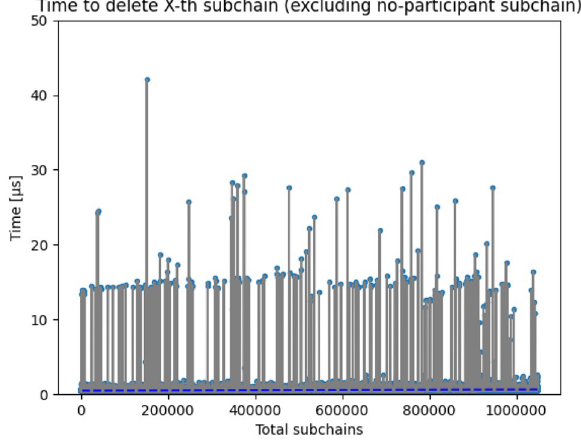
Figure 6. Time to delete subchain is not related to the number of other subchains in